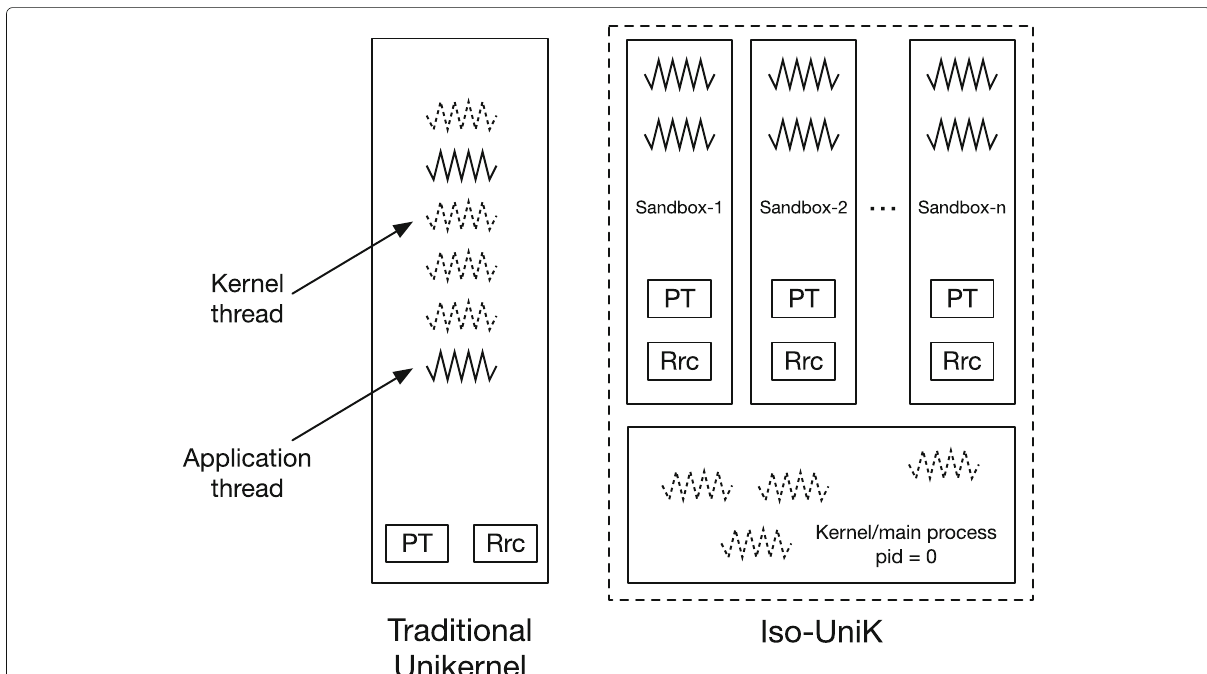
Fig. 2 Isolation between Sandboxes. Uses page table for inter-sandbox isolation. “PT” means page table, “Rrc” means resources